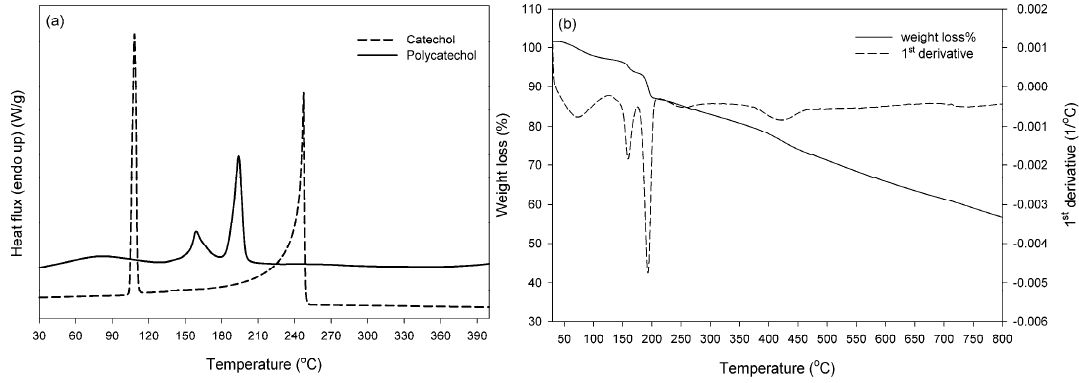
Figure 5. Thermal analysis curves ( a ) DSC and ( b ) TGA of enzymatically synthesized